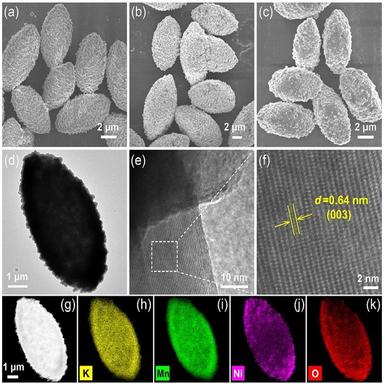
SEM images of (a) Mn0.7Ni0.3CO3 and (b) (Mn0.7Ni0.3)2O3. (c) SEM image, (d) TEM image, (e and f) HRTEM images, and (g–k) the corresponding elemental mappings of the KMNO cocoons.